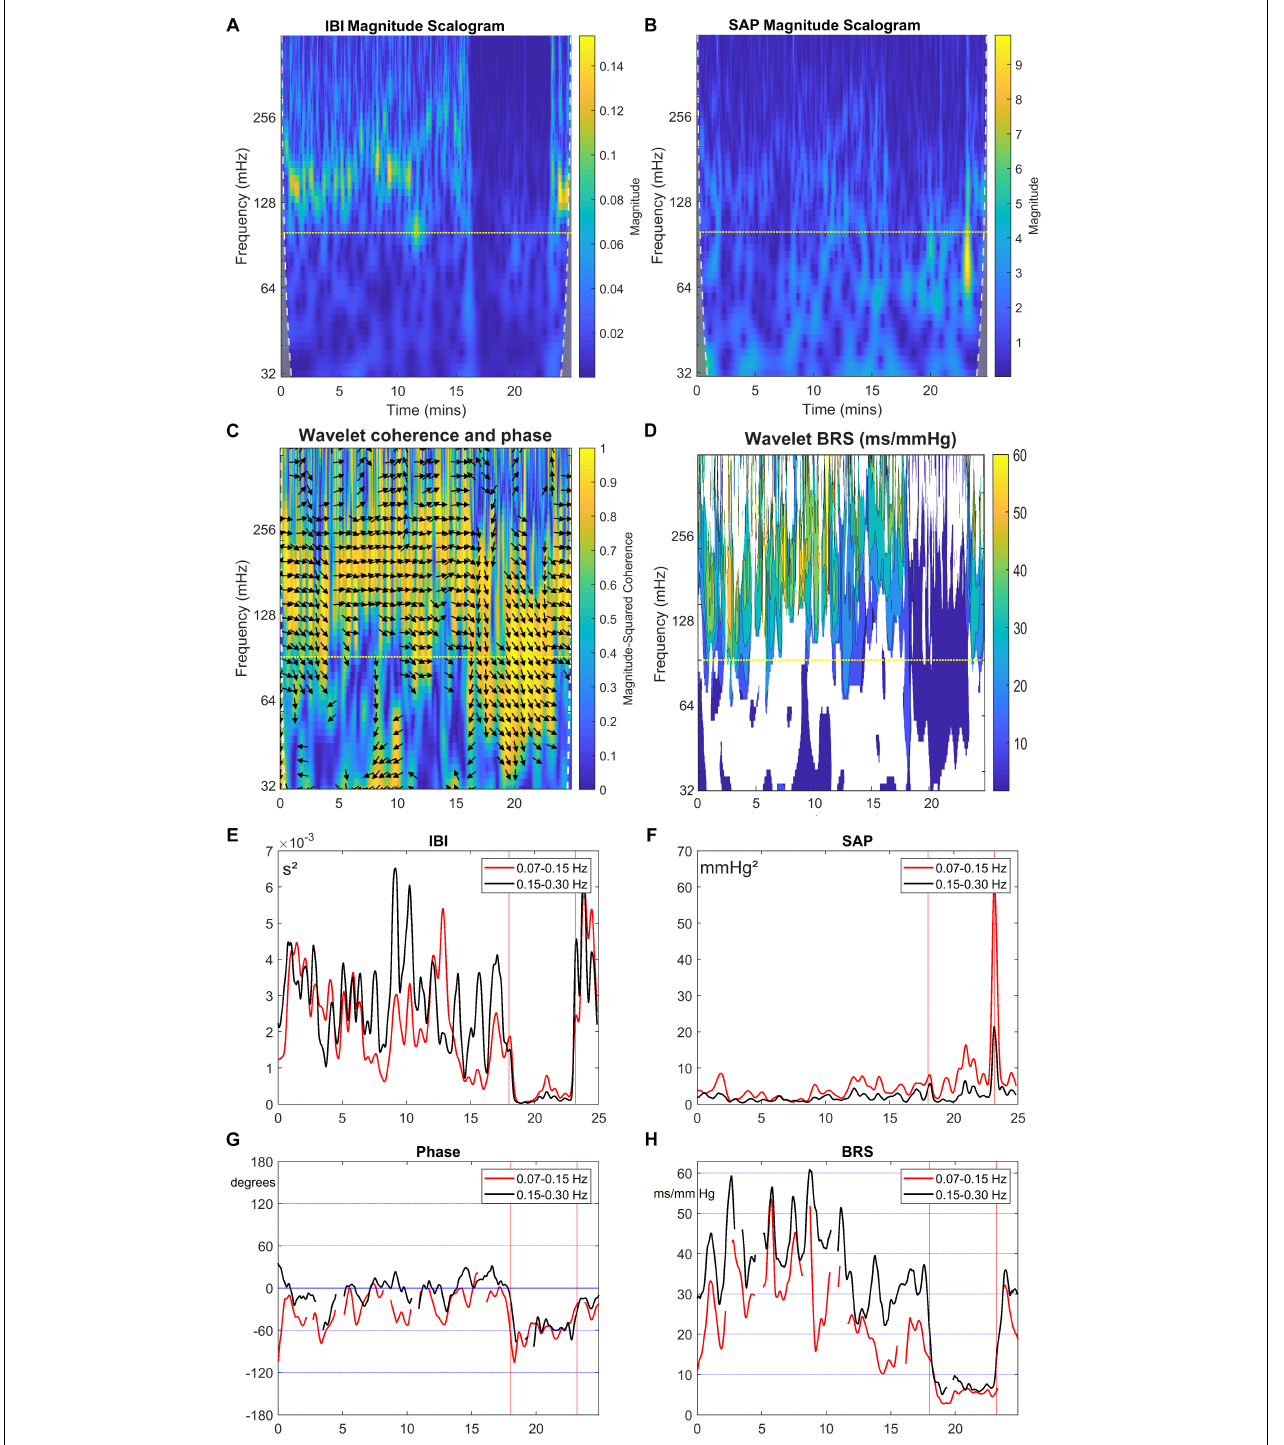
FIGURE 3 | Wavelet analysis of IBI and SAP variability, and resulting BRS and phase between SAP and IBI for the data from Figure 2 . The colors in the upper panels show the spectral power for each frequency and for each point of time, (A) for IBI and (B) for SAP. The 0.1 Hz frequency is indicated by a dotted line. (C) shows the wavelet coherence r 2 (color) and phase (arrows) between SAP and IBI. Arrows pointing in the 3 o’clock indicate zero phase difference. Phase is shown only where r 2 > 0.5. In (D) , the BRS is calculated from the data in the first two panels (only where r 2 > 0.5). In (E,F), the mean spectral power in the LF band (red line) and in HF band (black line) is shown for IBI and SAP variability. (G,H) show the mean phase between SAP and IBI and the mean BRS for both frequency bands. A negative phase implies SAP-variations leading IBI-variations.